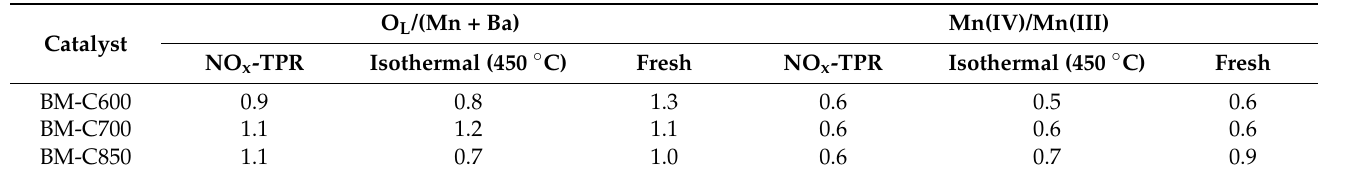
Table 4. XPS ratios of fresh and used BM-CX catalysts in successive NO x -TPR and isothermal